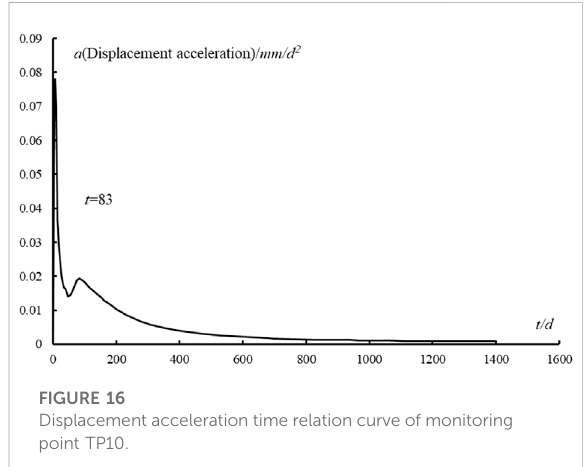
FIGURE 16 Displacement acceleration time relation curve of monitoring point